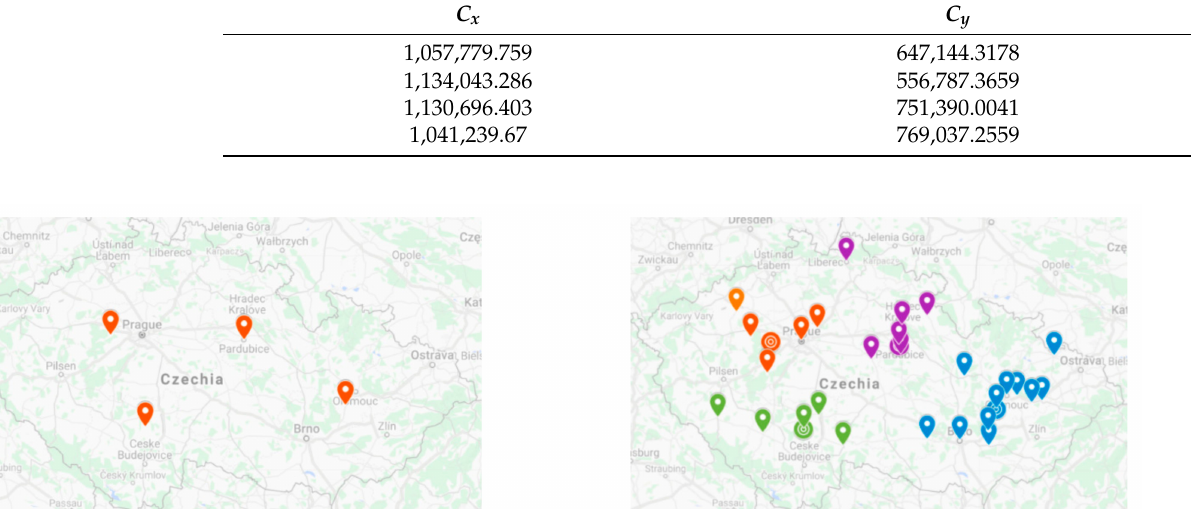
Figure 6. Representation of the best solution on map, left-only centers, right-centers and connected